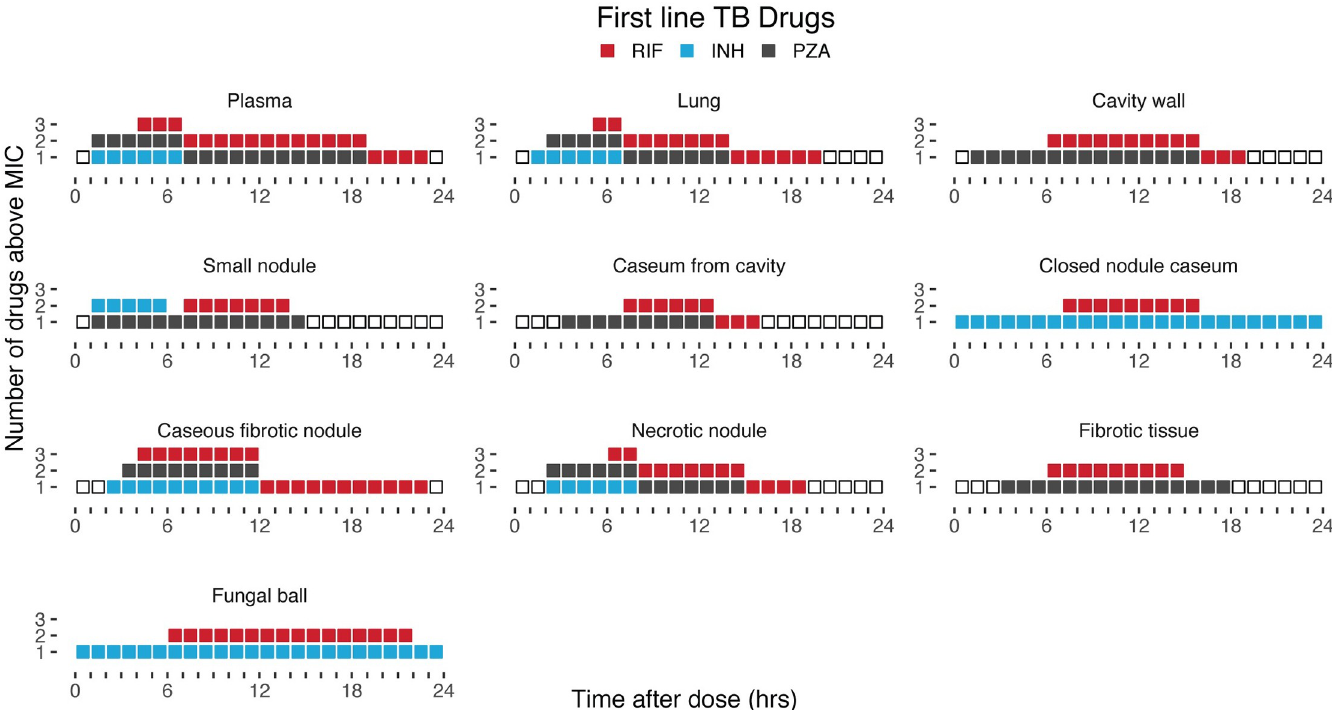
Fig 7. Number of drugs above MIC by lesion type. Number of drugs above MIC over time plot of first-line drugs at steady state, collected as the fifth percentile (low- exposure or at-risk patients) of 1,000 simulated patients over the 24-h dosing interval. Each square represents 1 h that a drug is above the MIC. The drugs are stacked for each hour with different colors representing different drugs. Empty squares show no drug on board. MIC, minimum inhibitory concentration.